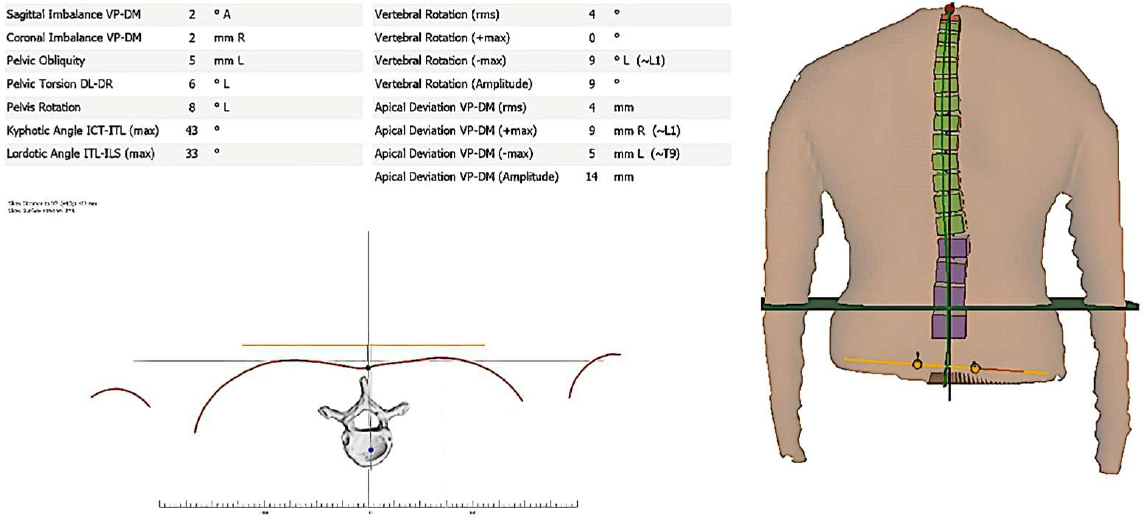
Figure 1. Illustrative example for the Formetric